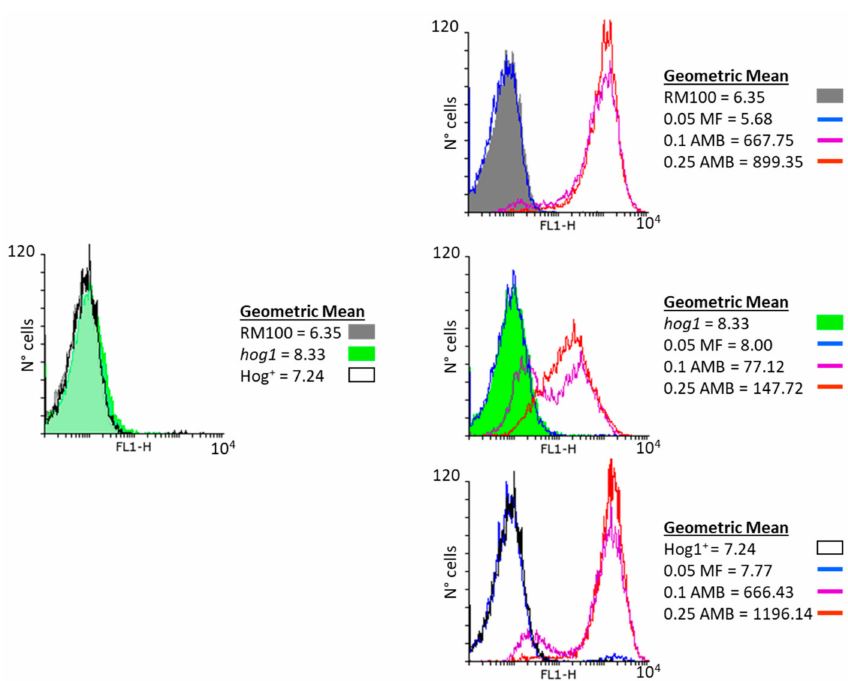
Figure 2. Quantification of intracellular ROS formation after treatment with MF and AMB. Exponential YPD-grown cells were incubated in phosphate-bu ff ered saline (PBS) in the presence of 0.05 mg / L MF, 0.1 mg / L AMB, or 0.25 mg / L AMB at 37 ◦ C. After 1 h, the level of intracellular ROS was quantified by flow cytometry using dihydrofluorescein diacetate (DHF) (40 µ M final concentration). Histogram on the left shows basal intracellular ROS of RM100 (filled dark-grey histograms), hog1 mutant (filled green histograms), and Hog1 + reintegrant (filled white-black line histograms). Histograms represent the total cell number with respect to the green (FL1) fluorescence intensity. The data shown are representative of three independent experiments. The geometric means of the fluorescence intensity are indicated in the text box for ROS